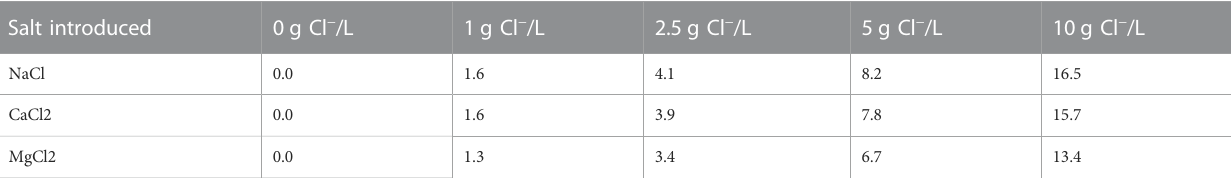
TABLE 2 Quantity of NaCl, CaCl 2 , and MgCl 2 added to un fi ltered stream water for each incubation concentration. Incubation concentrations are normalized to 1, 2.5, 5, and 10 g of chloride per liter. Salt